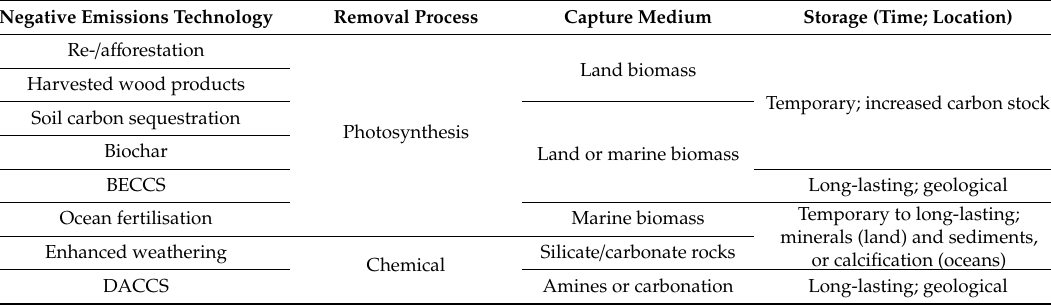
Table 1. Overview of characteristics of di ff erent negative emissions